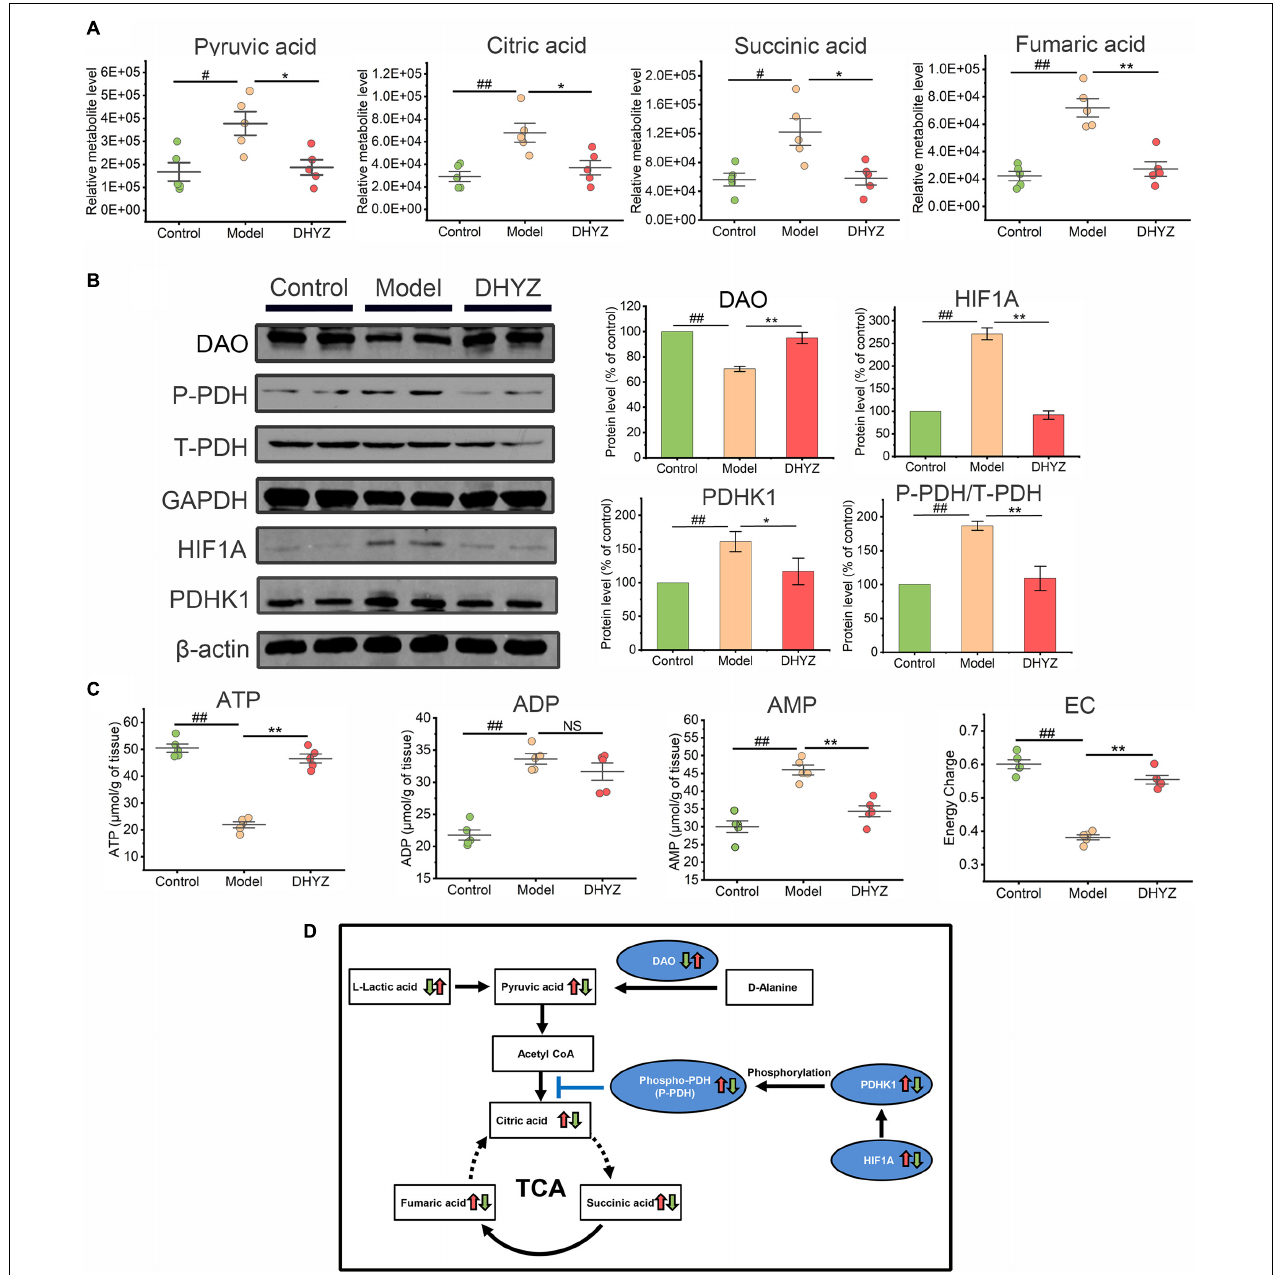
FIGURE 9 | The preservation effects of DHYZ on the tricarboxylic acid (TCA) cycle. (A) Metabolomics analysis illustrating the relative levels of urine pyruvic acid, citric acid, succinic acid, and fumaric acid ( n = 5). (B) The protein levels of DAO, phosphorylation of PDH, total PDH, HIF1A, and PDHK1 were measured by western blot analysis ( n = 3). (C) The levels of ATP, ADP, and AMP in the brain of mice in 3 groups was determined by reverse-phase HPLC assay ( n = 5). The energy charge (EC) was calculated as EC = ATP + 0.5ADP/(ATP + ADP + AMP). (D) Diagram depicting of protective effects of DHYZ on the TCA cycle in 2 × Tg-AD mice. All data are presented as the mean ± SEM. # P < 0.05 and ## P < 0.01, model vs. control; * P < 0.05 and ** P < 0.01, DHYZ vs. model. AD, Alzheimer’s disease; DHYZ, Dihuang-Yinzi; DAO, d-amino-acid oxidase; HIF1A, hypoxia-inducible factor 1-alpha; PDHK1, pyruvate dehydrogenase kinase 1; T-, P-PDH, total, or phosphorylated pyruvate dehydrogenase; ATP, adenosine triphosphate; ADP, adenosine diphosphate; AMP, adenosine monophosphate; EC, energy